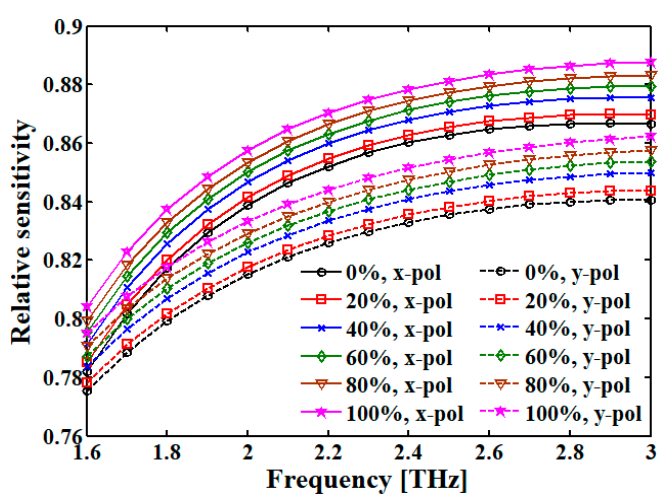
Figure 5. Relative sensitivity of this oil adulteration sensor at different air filling fraction at 2.8 THz and L = 280 µm.